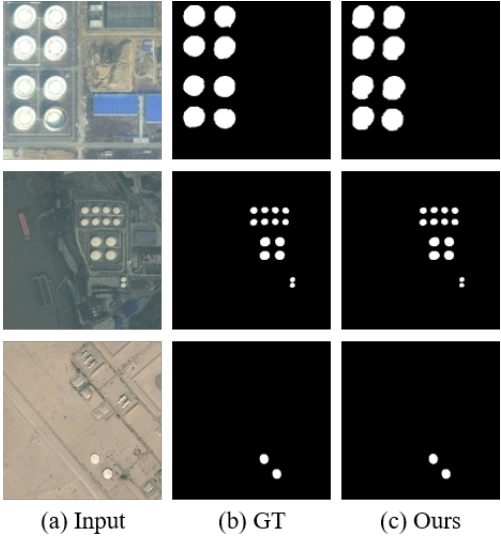
Figure 13. Our method works in misty and dusty condition. ( a ) is the input image, ( b ) is the ground truth, ( c ) is our